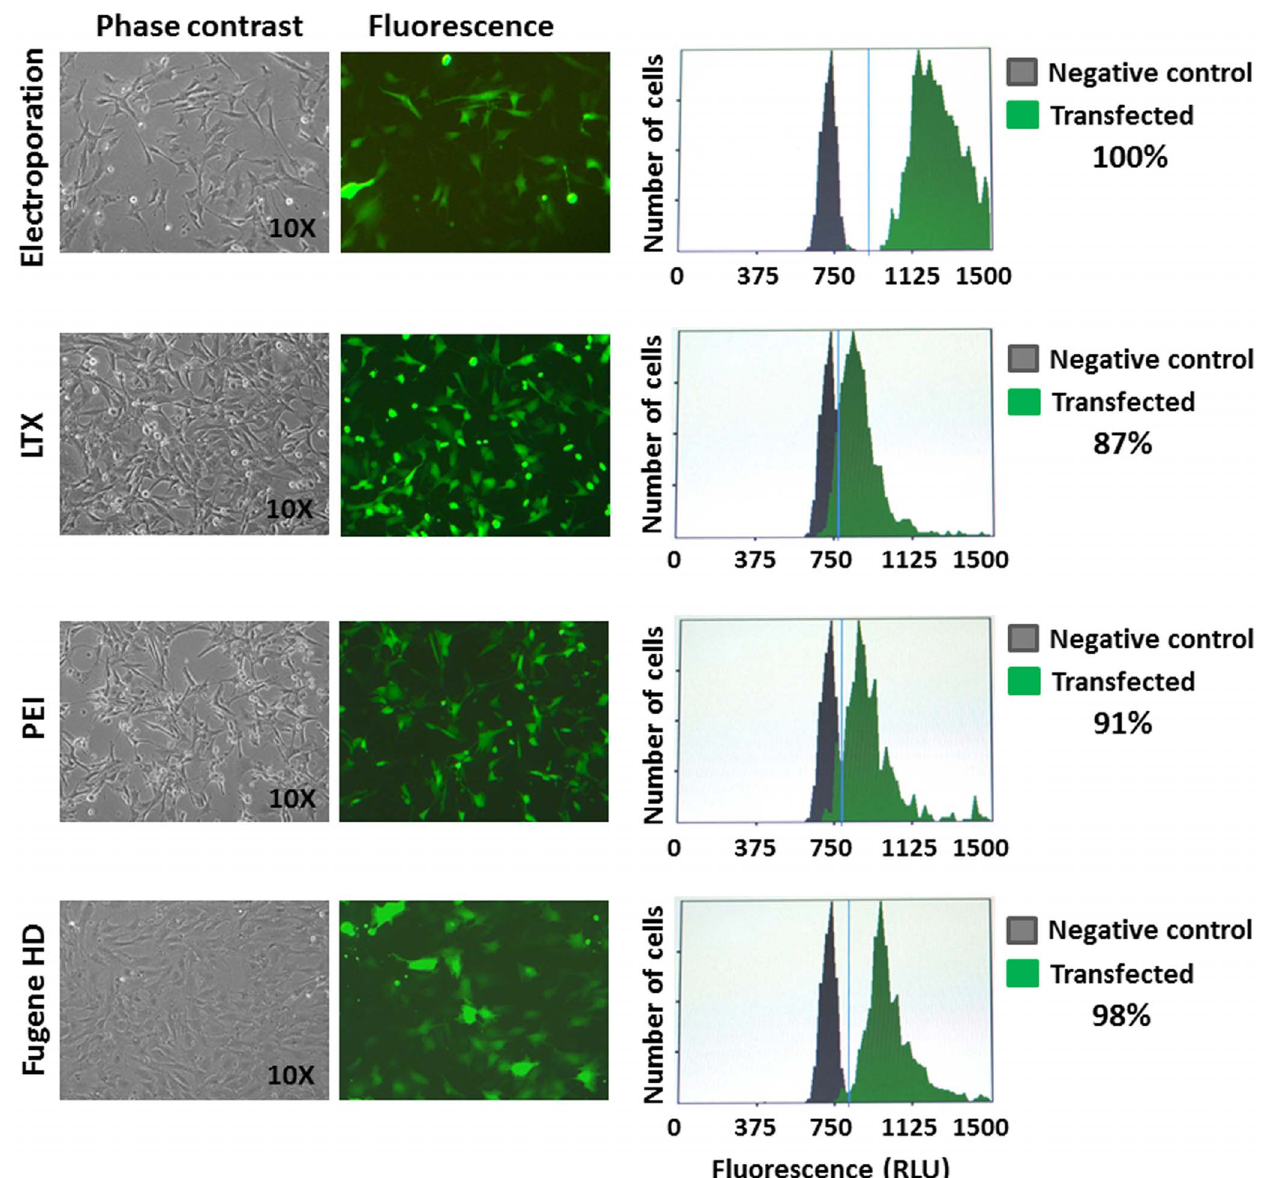
Figure 5. Transfection. Representative phase contrast and fluorescence images (10x) of ASSCs transfected with a GFP expression plasmid by different methods (Electroporation, LTX, PEI and Fugene HD), along with the efficiency of transfection as measured by cytometry. Each set of transfections was performed three times and standard deviations were negligible.